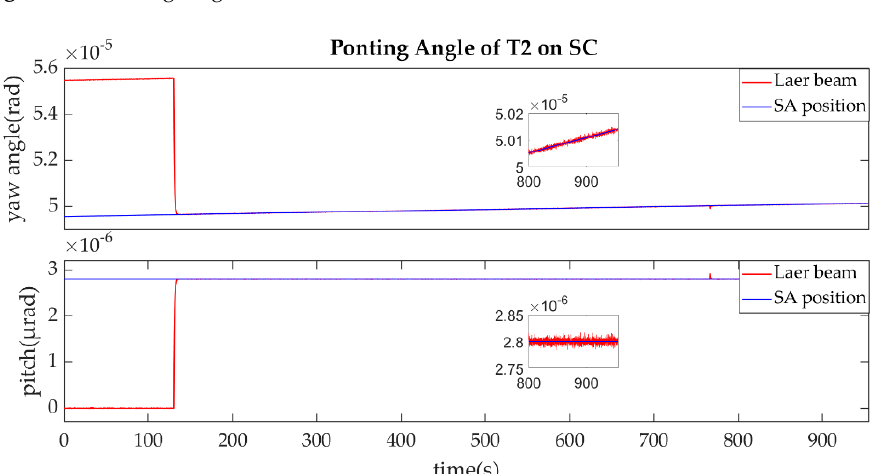
Figure 12. Pointing Angle Error of T1 on SA.